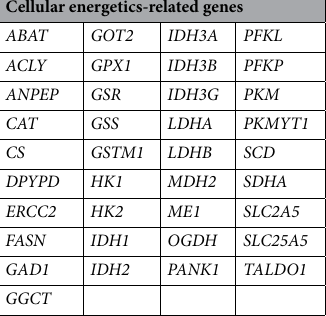
Table 1. Cellular energetics-related genes selected for the